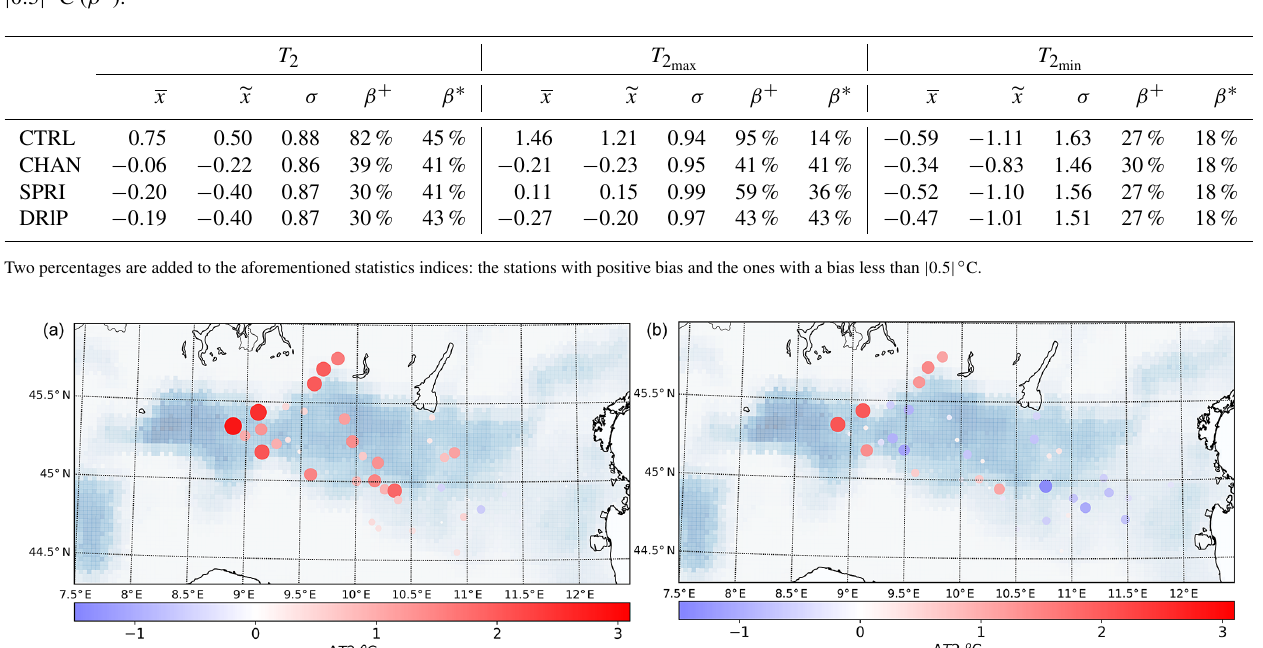
Table 3. Indexes for the monthly biases of the mean T 2 and the mean of the daily maximum and minimum temperatures for the valid stations: mean ( x ), median ( (cid:101) x ), standard deviation ( σ ), percentage of stations with positive bias ( β + ) and percentage of stations with a bias less than | 0 . 5 | ◦ C ( β ∗ ).